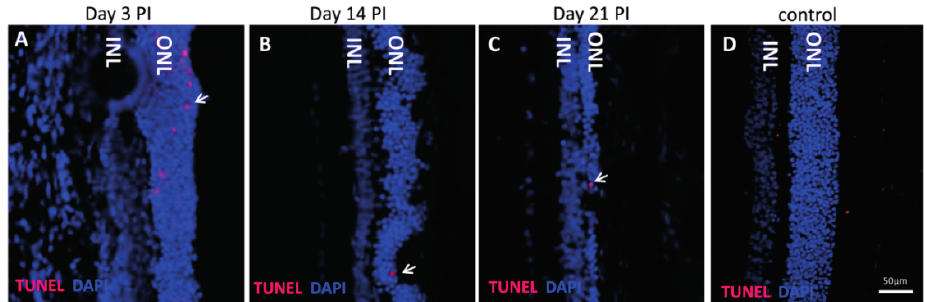
PRCs (red) were detected at day 3 post-injection; ( B ) The number of TUNEL-positive cells decreased until day 14 post-injection, indicating that the peak of apoptosis was past; ( C ) Two-to-three rows of PRC nuclei remained three weeks post-induction of the degeneration; ( D ) No TUNEL-positive cells were found in the ONL of the control samples. ONL = Outer nuclear layer; INL = Inner nuclear layer. Arrows mark individual TUNEL-positive